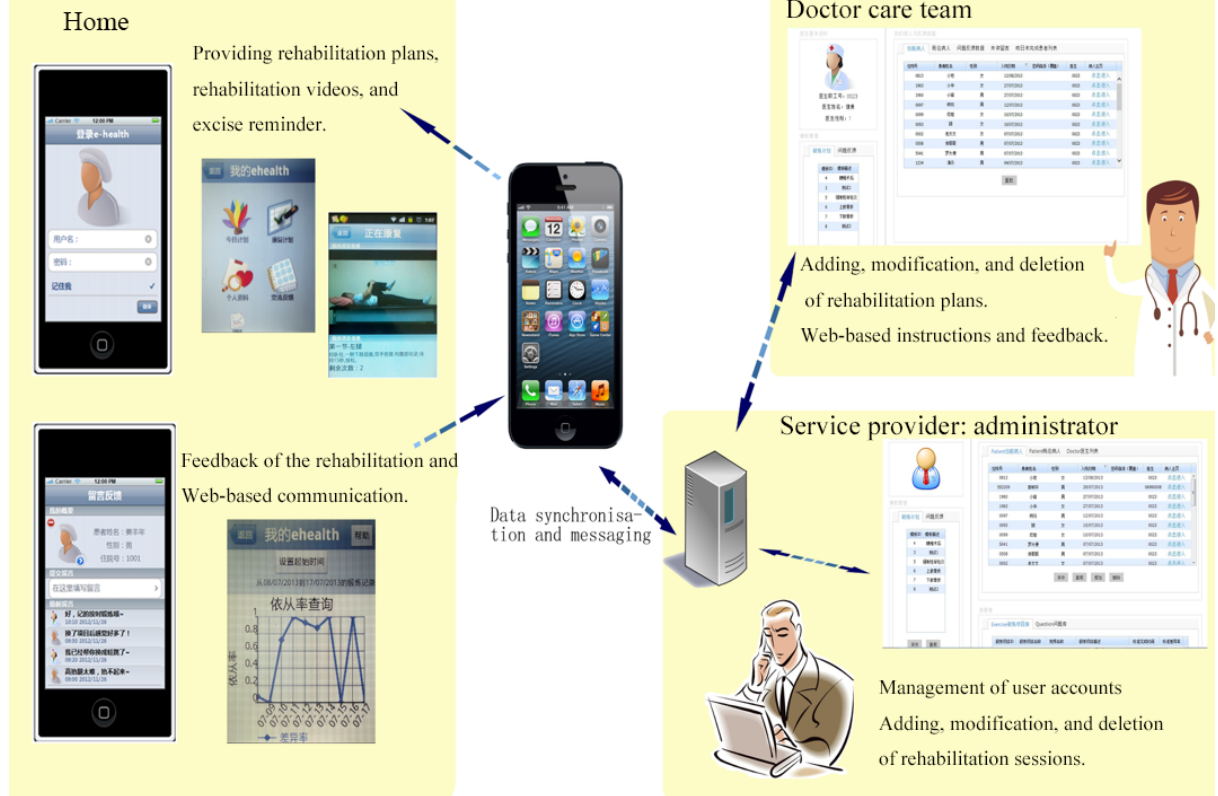
Figure 1. The eHealth system contained 2 interfaces: mobile phone–based interface and Web-based interface. Through mobile phone–based interface, patients were able to view the rehabilitation plans and conduct their rehabilitation following the video instructions. Daily reports and an alert were sent to prompt them to return to this system. They could also communicate with doctors through this system. Through Web-based interface, the doctors could adjust rehabilitation plans for patients and view reports about their daily exercise. All data were synchronized and stored in a remote